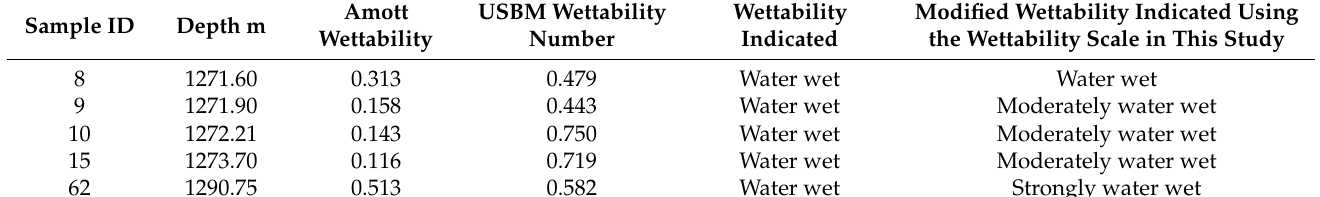
Table 5. Initial wettability states and modified wettability states for core samples. Sample ID